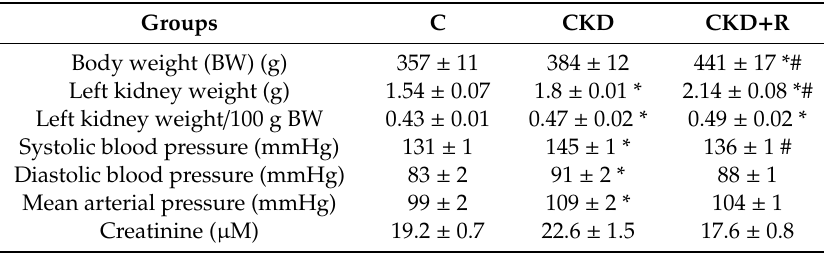
Table 1. Weights, blood pressure, and renal